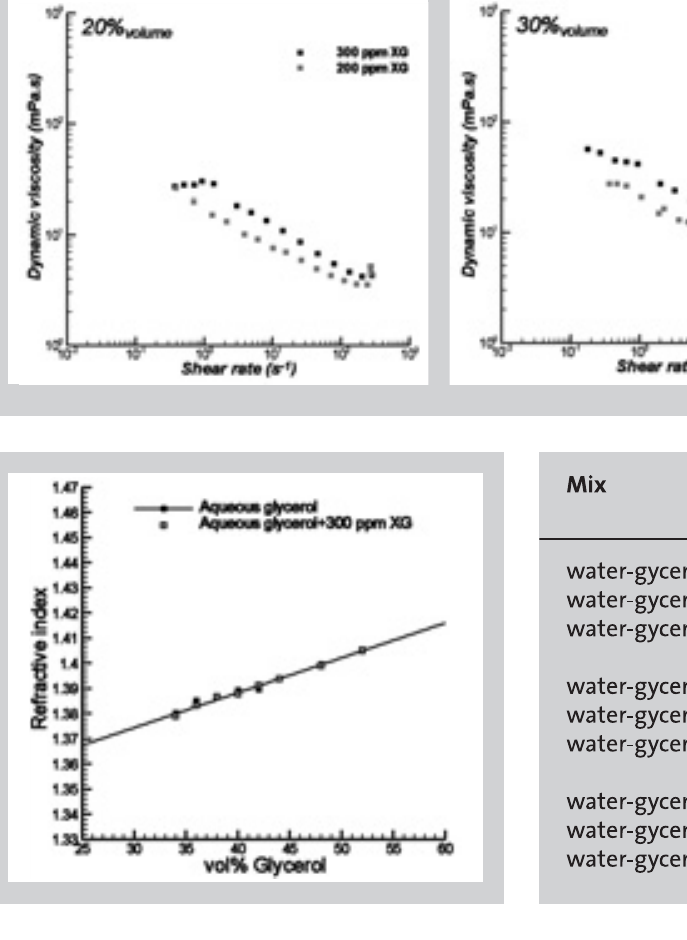
Figure 1 (above): Viscosimetric evolution of the aqueous glycerol solu- tions with 200 and 300 ppm of xanthan gum (XG) at 25°C. Figure 2: Refractometric evolution of the aqueous glycerol solu- tions with 200 and 300 ppm of xanthan gum at 25°C. Table 2: Extremum dynamic viscosi- ty values (mPa.s) at